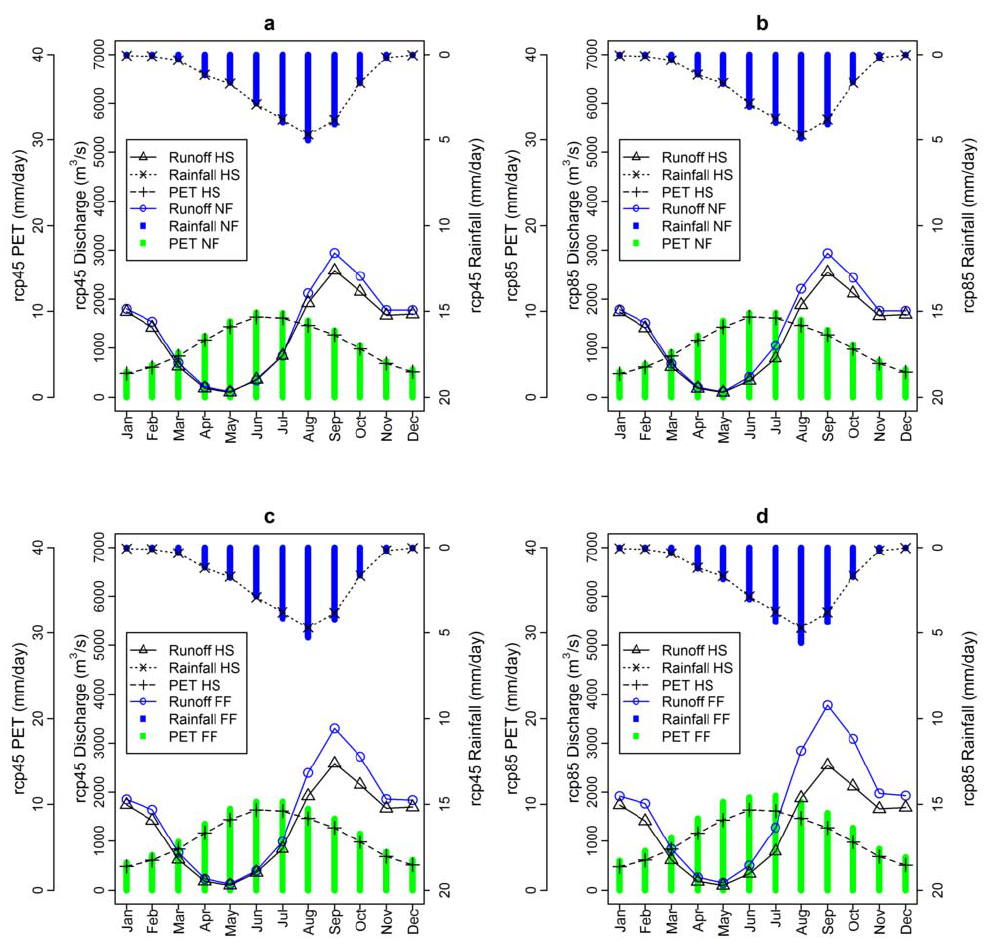
Figure 6. Monthly ensemble (8 GCMs) mean discharge response to changes in climate variables for